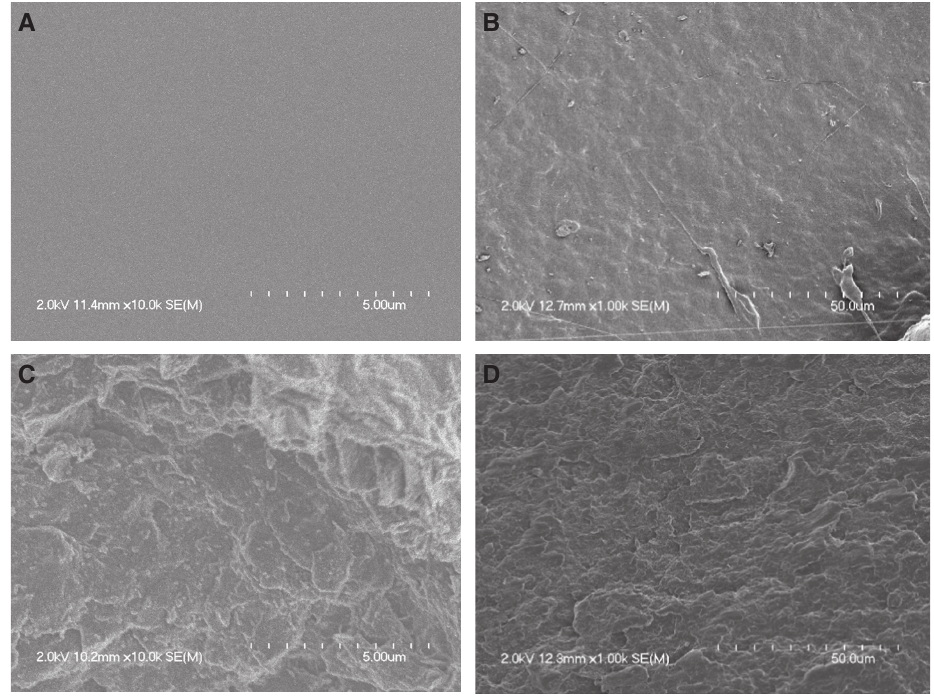
Figure 4 Morphologies of fracture surface of neat PBS (A and B) and 4% PBS/clay composites (C and D).